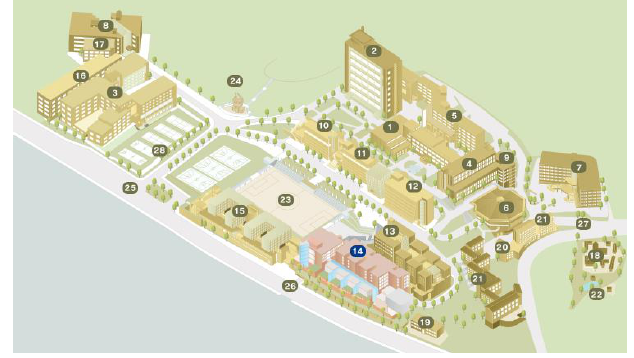
Figure 7. Kookmin University’s Campus.